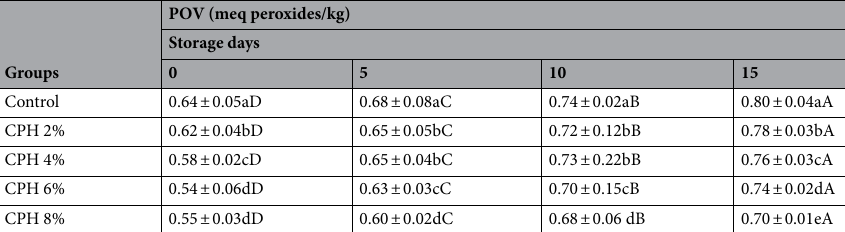
Table 4. POV of casein protein hydrolysate (CPH) incorporated beef nuggets during storage. CPH: casein protein hydrolysate. All the values are means of triplicate determinations ± Standard Deviation (SD). Means within the column with different small letters are significantly different (p < 0.05) and different capital letters within the row differed significantly.